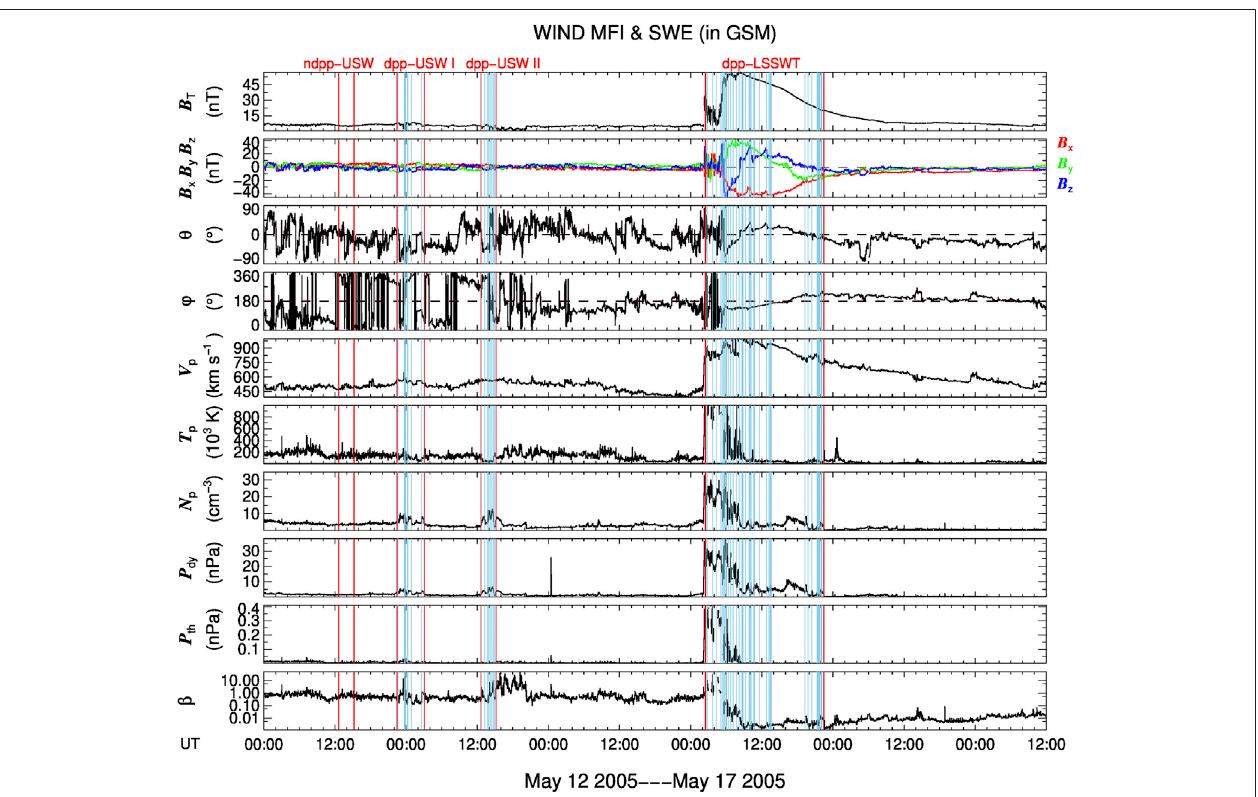
FIGURE 7 | Magnetic fi eld and plasma parameters of solar wind observed by WIND from May 11, 2005 to May 17, 2005. The panels from top to bottom are: magnetic- fi eld magnitude, the three components (x, y, z) of the magnetic fi eld in Geocentric Solar Magnetospheric (GSM) coordinates, magnetic- fi eld latitude angle, magnetic- fi eld azimuthal angle, proton bulk speed, proton temperature, proton density, solar wind dynamic pressure, proton thermal pressure, and plasma beta, respectively. The four discussed regions, ndpp-USW region, dpp-USW I region, dpp-USW II region, and dpp-LSSWT region, are labeled by the red vertical lines, respectively. The center of the transition regions of the captured DPP events are marked by sky blue vertical lines separately.